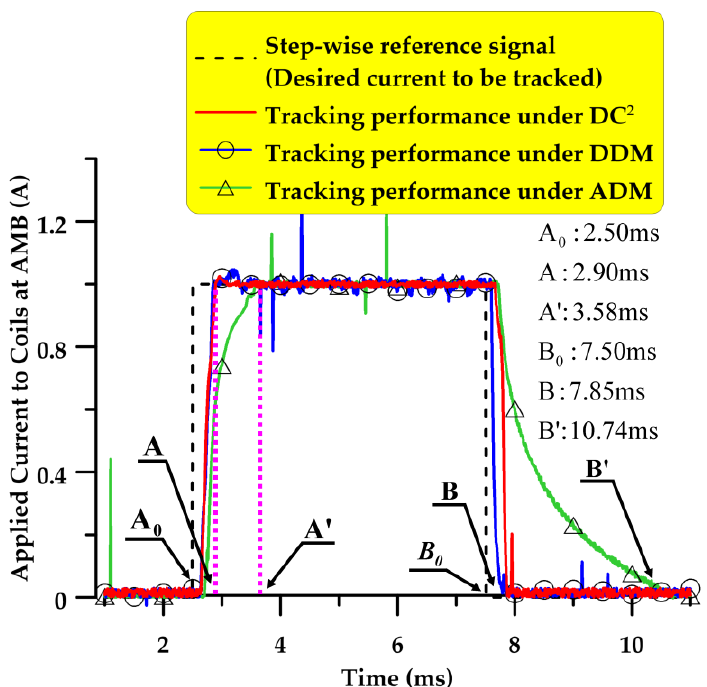
i under DDM (digital driving mode), ADM (analog Figure 16. Tracking performances of i A M B AMB under DDM (digital driving mode), ADM (analog driving